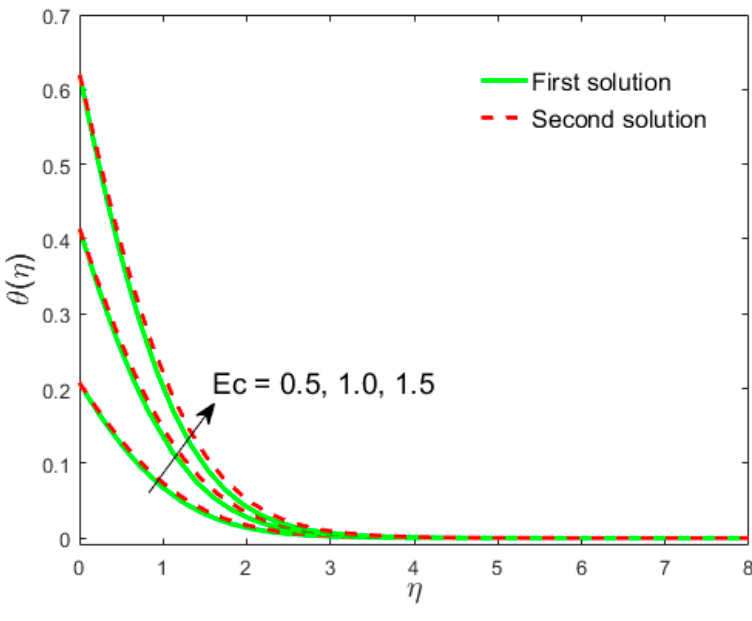
Figure 12. Effect of Ec on ( ) Figure 12. E ff ect of Ec on θ ( η ) .